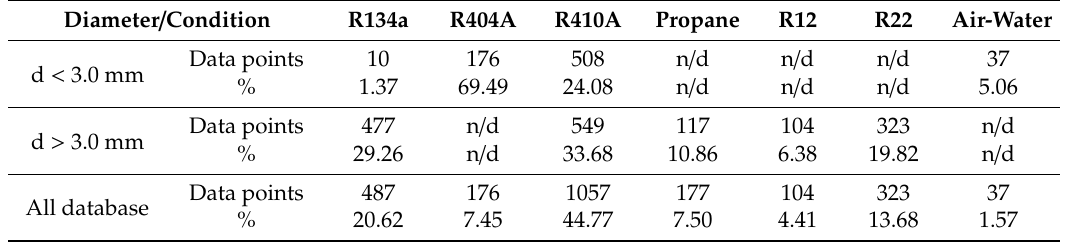
Table 5. Database